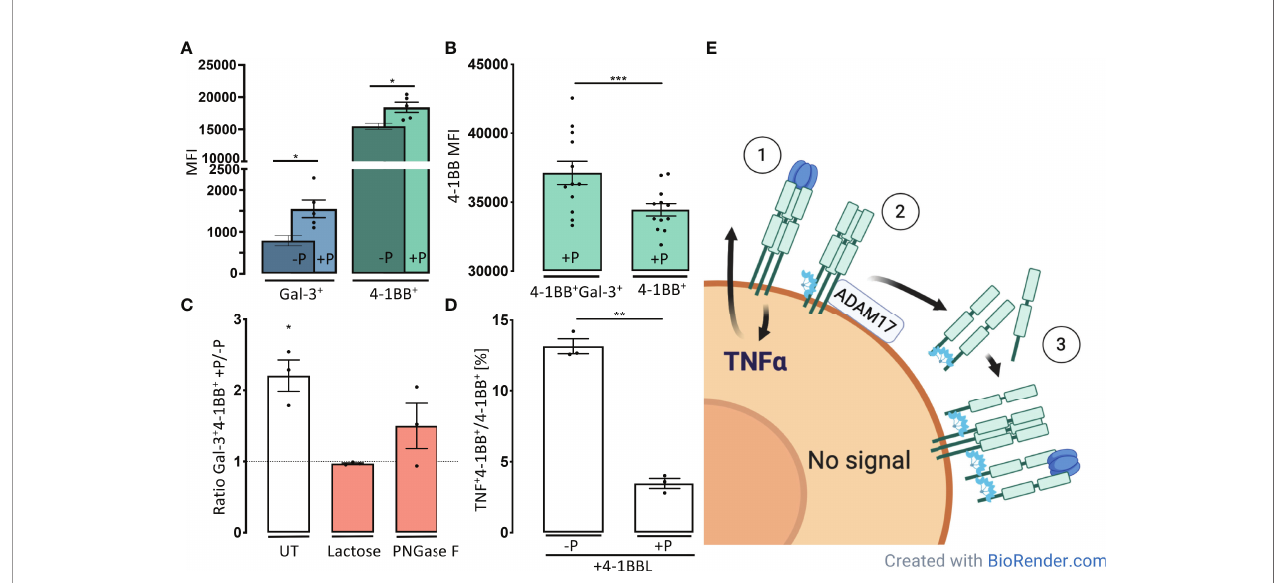
FIGURE 4 | Gal-3 forms complexes with s4-1BB that can attach to the cell surface and shield cells from 4-1BBL induction of TNF a . (A) CD3/CD28-activated CD4 T-cells were incubated for 30 minutes at 37°C with (+P), or without, plasma (-P) from healthy controls (HC). Cells were then examined by fl ow cytometry for the membrane median fl uorescence intensity (MFI) of Gal-3 measured on 4-1BB+Gal-3+ CD4+ T cells (Blue) and MFI of 4-1BB measured on 4-1BB+ CD4+ T cells (Green). Bars represent mean (SEM) as ratio of MFI on cells incubated +/- plasma (n = 5, *P < 0.05). (B) Expression of 4-1BB on 4-1BB transfected HEK293 cells after incubation with plasma (+P) from healthy controls. Cells that were doublet positive for 4-1BB and Gal-3 showed a signi fi cant higher 4-1BB MFI compared with single positives (n = 12). Data are expressed as mean ± SEM, Student ’ s paired t-test, ***P < 0.001. (C) The proportion of Gal-3 + and 4-1BB + T cells were increased after 30 minutes incubation in HC plasma. The proportion of the double positive Gal-3+4-1BB+ cells decreased by addition of Lactose or PNGase F, compared with untreated (UT). Bars represent mean (SEM) as ratio of Gal-3+4-1BB+ cells with or without HC plasma (n = 3, *P < 0.05). (D) Activated CD4 + , 4-1BB + T cells incubated with or without, plasma from healthy controls and subsequently stimulated with 4-1BBL. Plasma preincubation reduced CD4 T-cells ability to produce TNF a upon 4-1BBL stimulation (n = 3). Bars represent mean (SEM) as ratio of TNF a producing 4-1BB+ CD4 T cells out of all 4-1BB+ CD4 T cells **P < 0.01. (E) Based on our results, we suggest a model where 4-1BBL induce TNF a synthesis ① and Gal-3 increases shedding of 4-1BB ② . Gal-3 mediates complex formation engaging with s4-1BB. These 4-1BB/Gal-3 complexes reassemble on the cell surface by binding to membrane expressed 4-1BB ③ , creating a decoy mechanism that blocks for further 4-1BBL